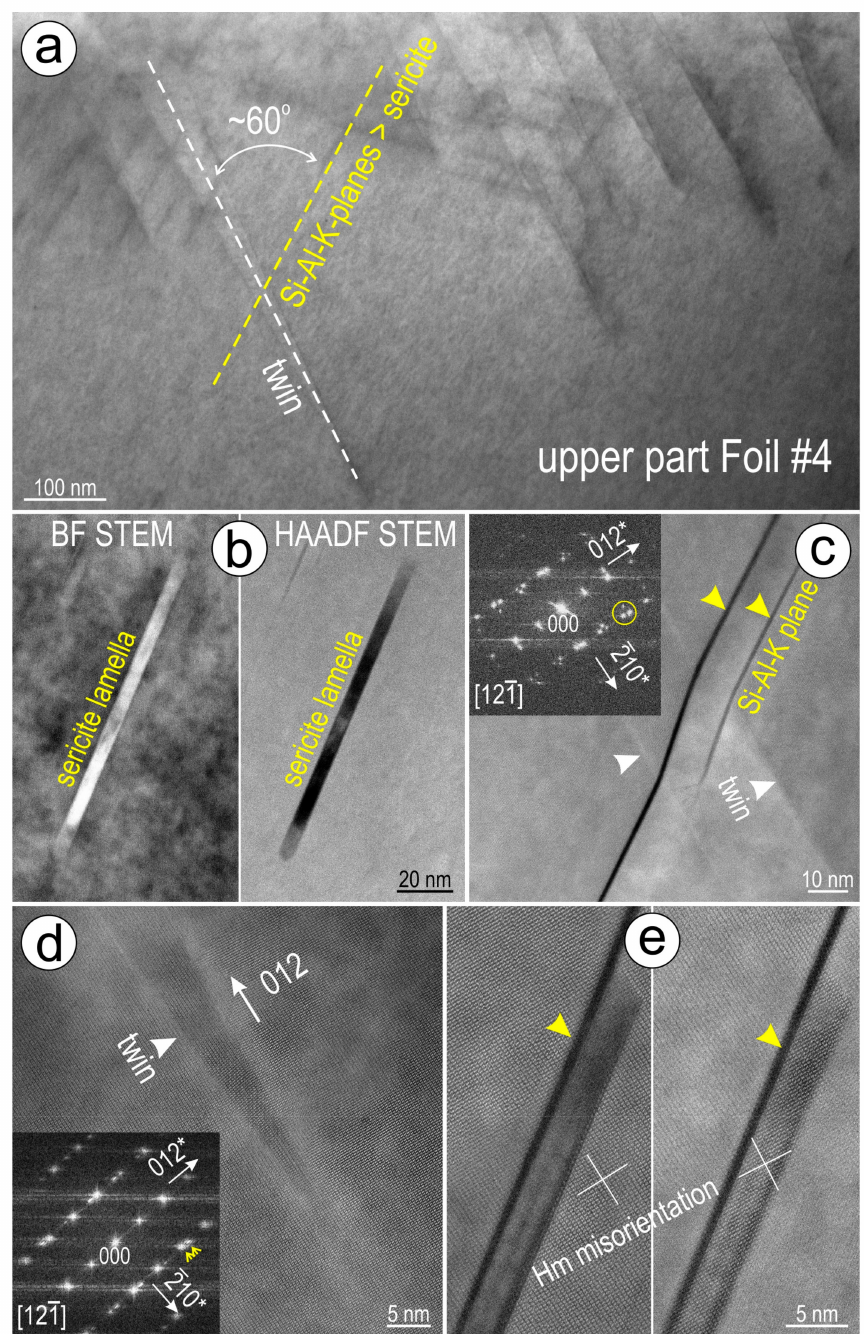
Figure 10. ( a ) HAADF (and bright field (BF) where marked) STEM images showing aspects of weaved-twin hematite at the upper part of foil #4. ( a ) Sets of twins and crosscutting Si-Al-K planes crosscutting at ~60 ◦ . ( b ) Platelets of sericite found in continuation of Si-Al-K planes. Comparison between BF and HAADF STEM images shows much of the filling is lost most likely plucked out during the FIB milling. ( c ) Conjugate sets of Si-Al-K planes (yellow arrows) crosscutting twins (white arrows) in hematite imaged on [121] zone axis. Such crosscutting relationships are marked by groups of satellite reflections (circled) along (210)* and parallel lattice vectors as shown on the FFT (inset). ( d ) Twinned hematite imaged on the [121] zone axis. The twin planes along (012) directions are marked by a split in reflections along the (210)* and parallel lattice vectors (FFT in inset). ( e ) Sliver of hematite adjacent to a Si-Al-K-plane (yellow arrow) imaged on the same [121] zone axis but with di ff erent focus to show the slight misorientation (white crosses) relative to the enclosing